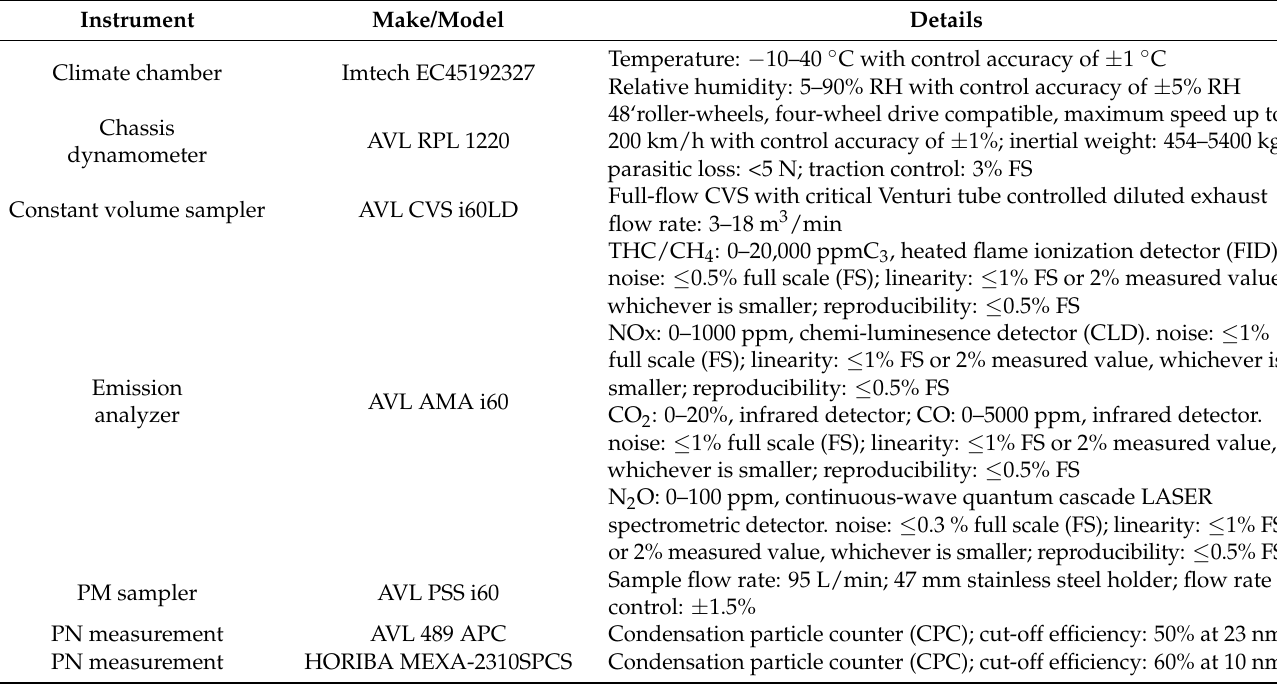
Figure 1. Systematic sketch of the test facilities. Table 1. Specifications of the testing instruments.